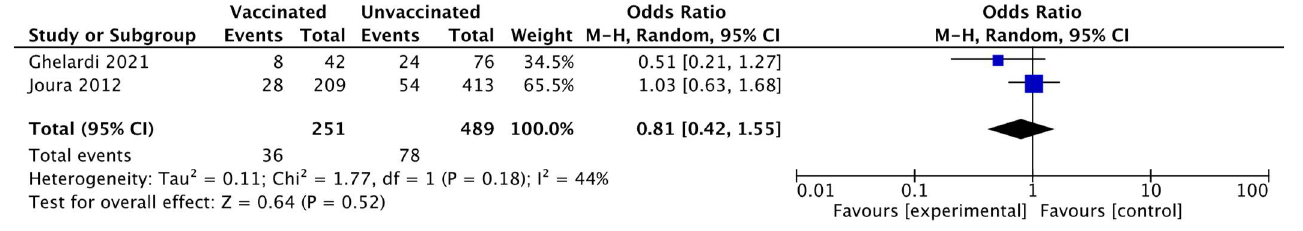
Figure 9. Forest plot of comparison: VIN/VaIN recurrence.